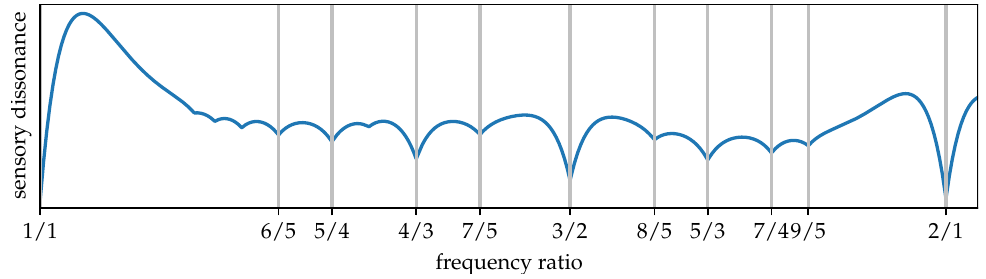
Figure 5. Sensory dissonance for dyads in terms of their frequency